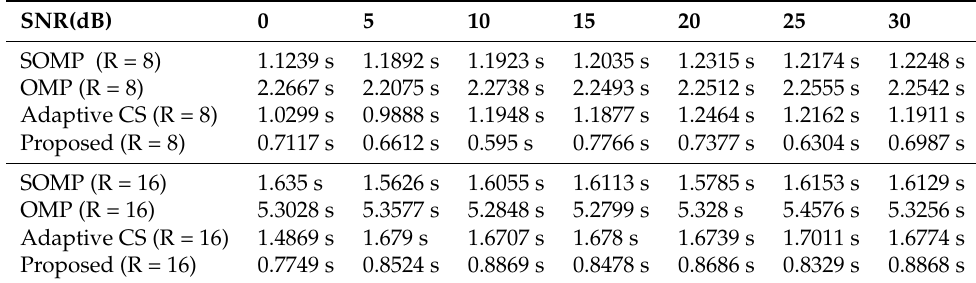
Table 4. Average run time of respective